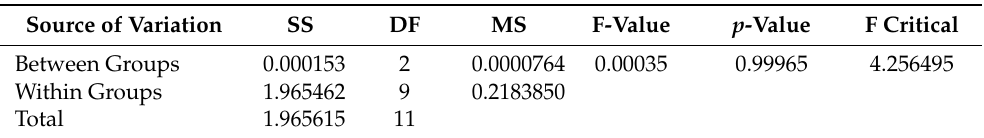
Table 8. ANOVA: Pressure Single Factor (NF).